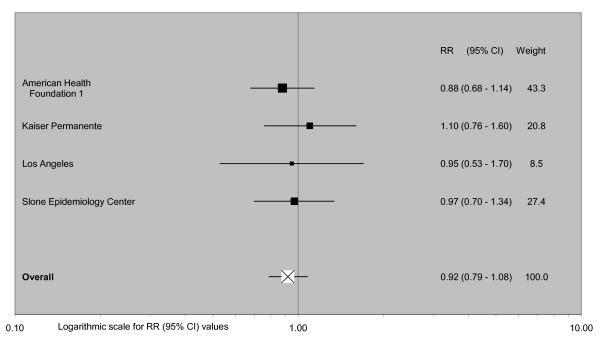
Forest plot of study-specific estimates and 95% CIs for long-term use of mentholated cigarettes. The figure plots the four combined gender/combined race estimates for long-term use of mentholated cigarettes in ever smokers (or current smokers if not available). Precise definitions of the comparison used for each study are given in Table 19. Each estimate is shown as a square with its area proportional to its weight. The CI is indicated by a horizontal line. The data are plotted on a logarithmic scale so that the estimate is centred in the CI. Also shown in the plot are the actual values of the estimate and its CI and weight. Results from a random effects meta-analysis are also shown. The combined estimate is presented as a diamond with the width corresponding to the CI, and the estimate as the centre of the diamond.